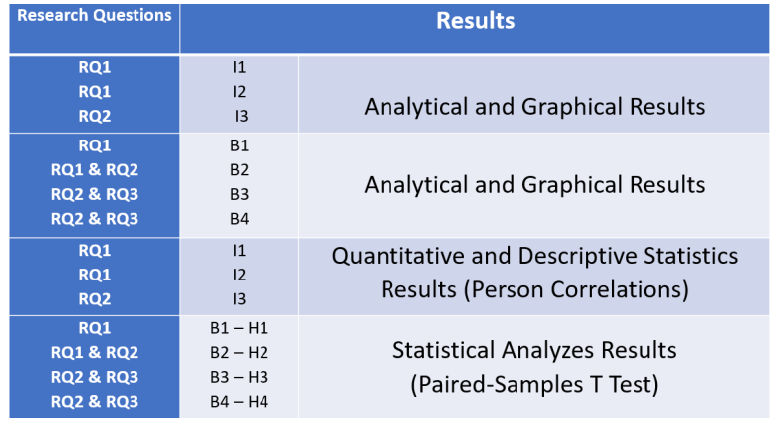
Figure 4. Results section structure.